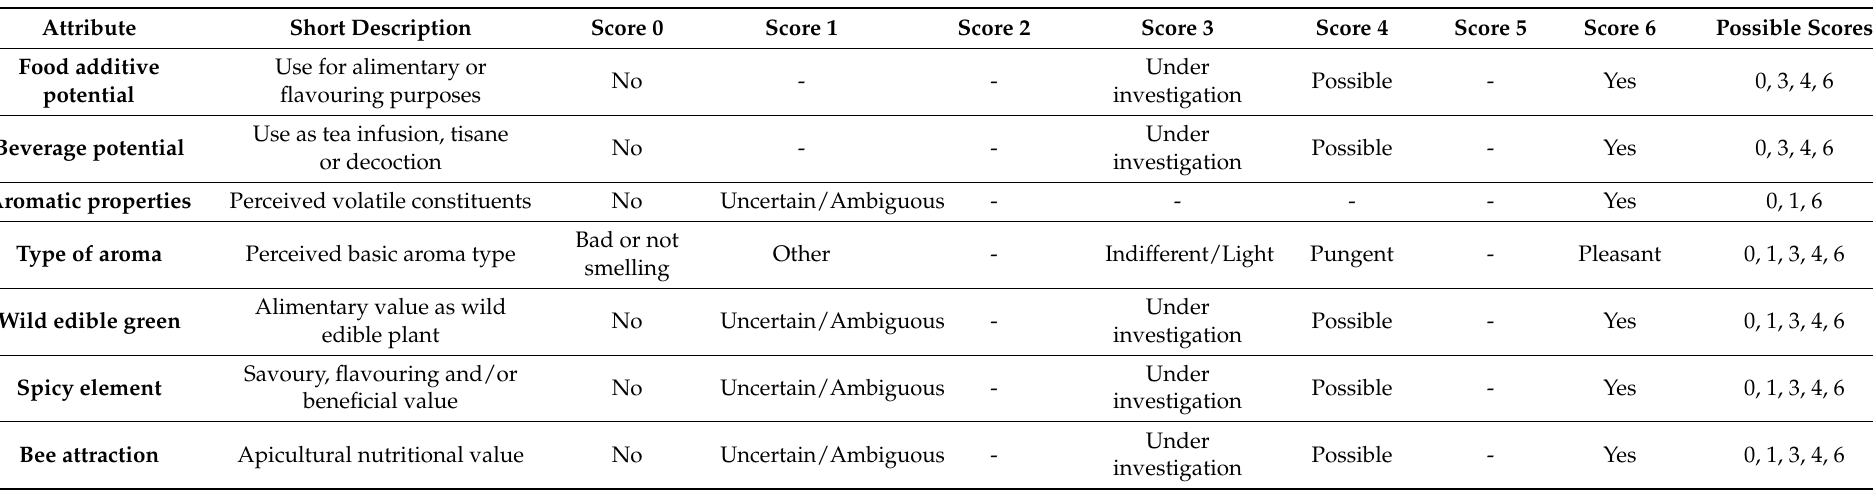
Table 2. Sector-specific attributes and score values selected for the evaluation of the agro-alimentary potential (Level I evaluation, L-I) of the local endemic plants of Crete (Greece), Rif and Mediterranean coast of Morocco, and Tunisia, outlining the escalation of interest and the directionality of scoring. For examples on scoring of the studied taxa, guidelines and data sources used see Supplementary Material S1. For scoring of attributes of Levels II and III, see